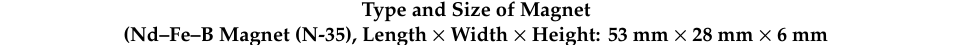
Table 6. Gauss calculation by distance [42].